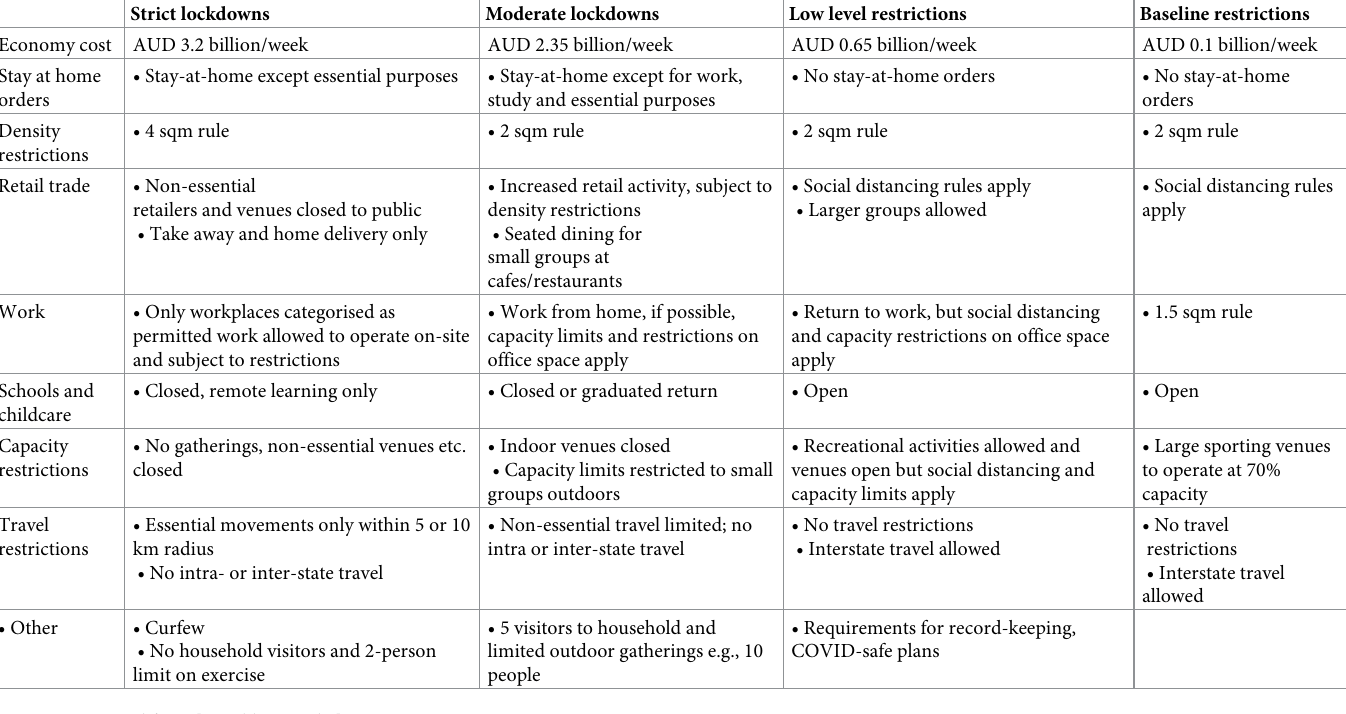
Table 5. Australian Public Health Measures and Economy Costs by Stringency of Public Health Measures.